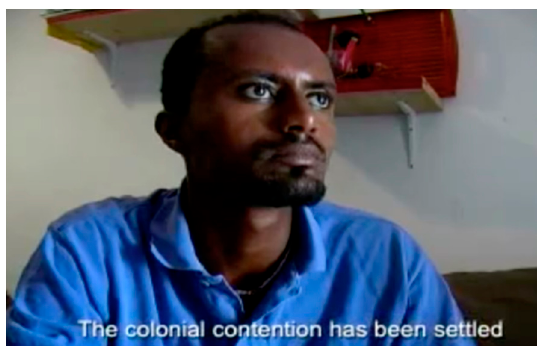
Figure 1. Dagmawi Yimer (Ethiopian) watches Italian news where the journalist states that, thanks to the agreement between Berlusconi and Gaddafi, “the colonial contention has been settled” (still frame, used by permission). The documentary seems to show how this story is part of a neo-colonial politics of Italy towards Libya (and of Europe towards Africa).